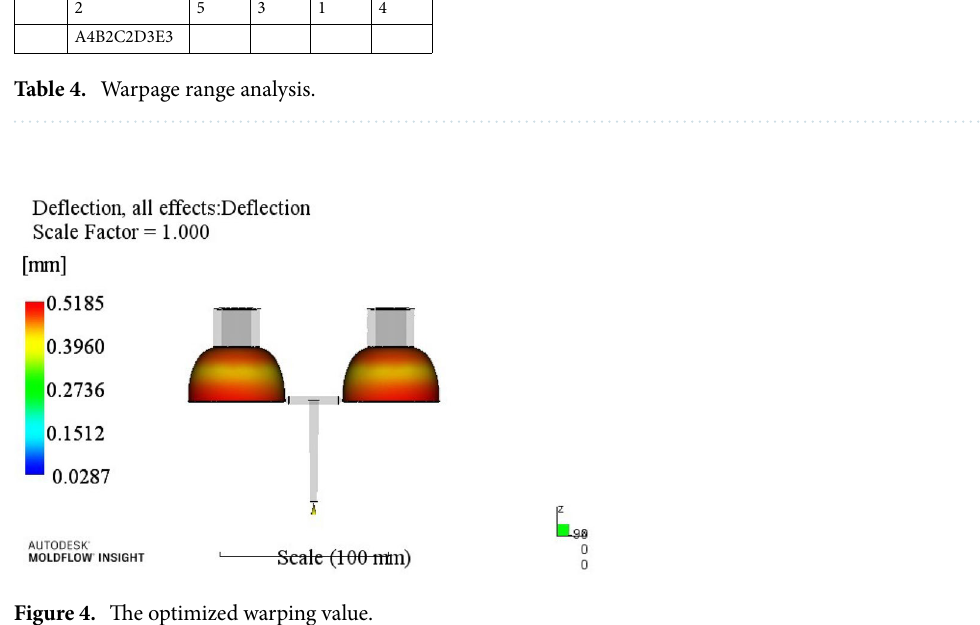
Figure 4. The optimized warping